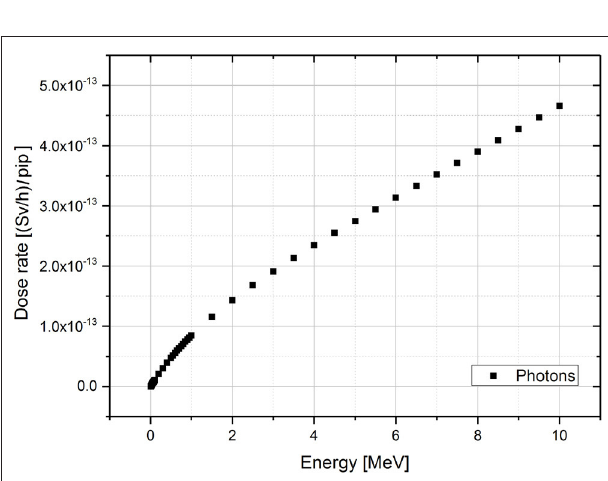
FIGURE 3 | Dose rate results of MCNPX simulations for monoenergetic gamma sources per incident particle (pip). The range of simulated energies goes from 0.01 to 10